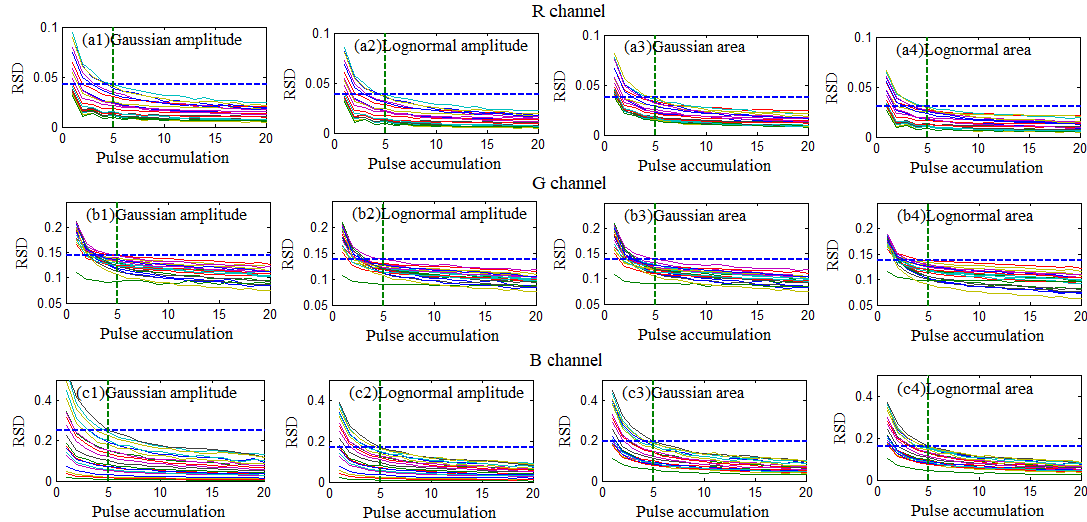
Figure 7. Color restoration results in terms of the RSD (relative standard deviation) by using Gaussian amplitude, lognormal amplitude, Gaussian area and lognormal area with the number of accumulated pulses ranging from 1 to 20. The top row ( a1 – a4 ) depicts the results using the four types of intensity as input data at the R channel. The middle row ( b1 – b4 ) depicts the results using the four types of intensity as input data at the G channel. The bottom row ( c1 – c4 ) displays the results using the four types of intensity as input data at the B channel. Each sub-figure consists of color restoration results that vary with accumulated pulses shown as different colored lines. Different colored lines represent 24 colored squares of the color checker.